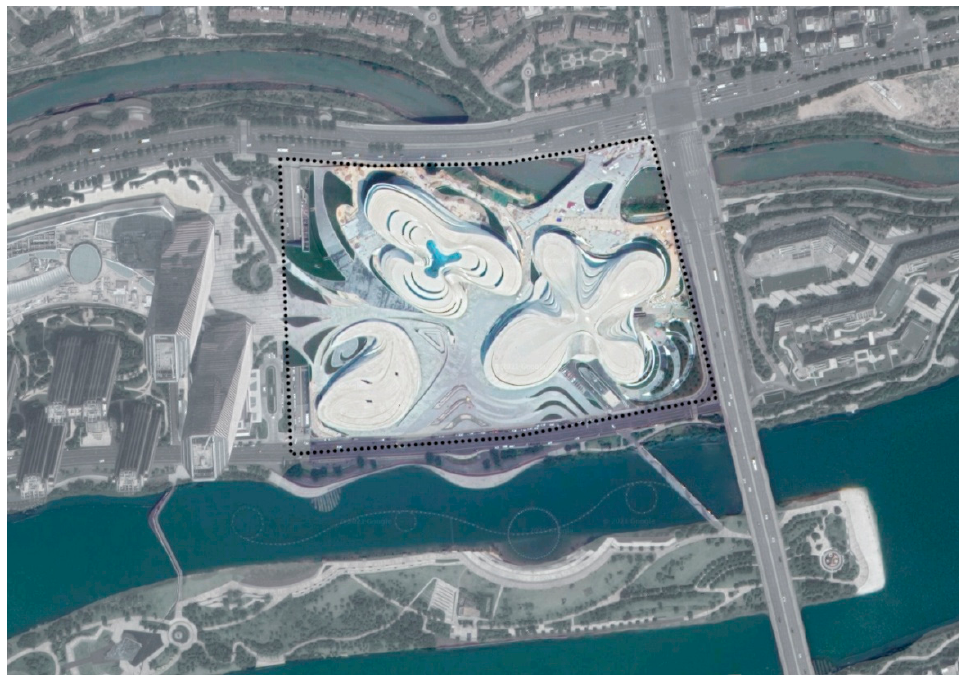
Figure 17. Context of Changsha Meixihu International Contemporary Art Museum, graphic processing, based on [37] by E. Latusek.